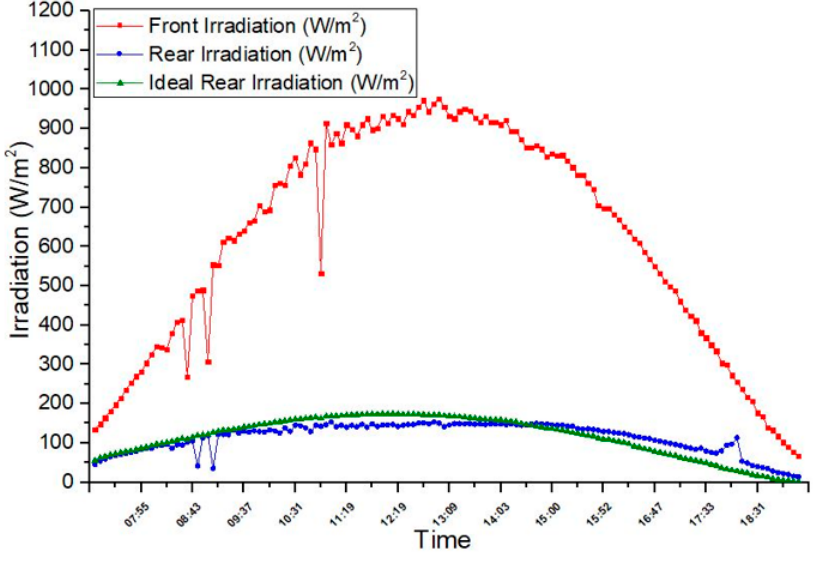
Figure 18. Irradiation data obtained from the measurements of the front pyranometer, the rear